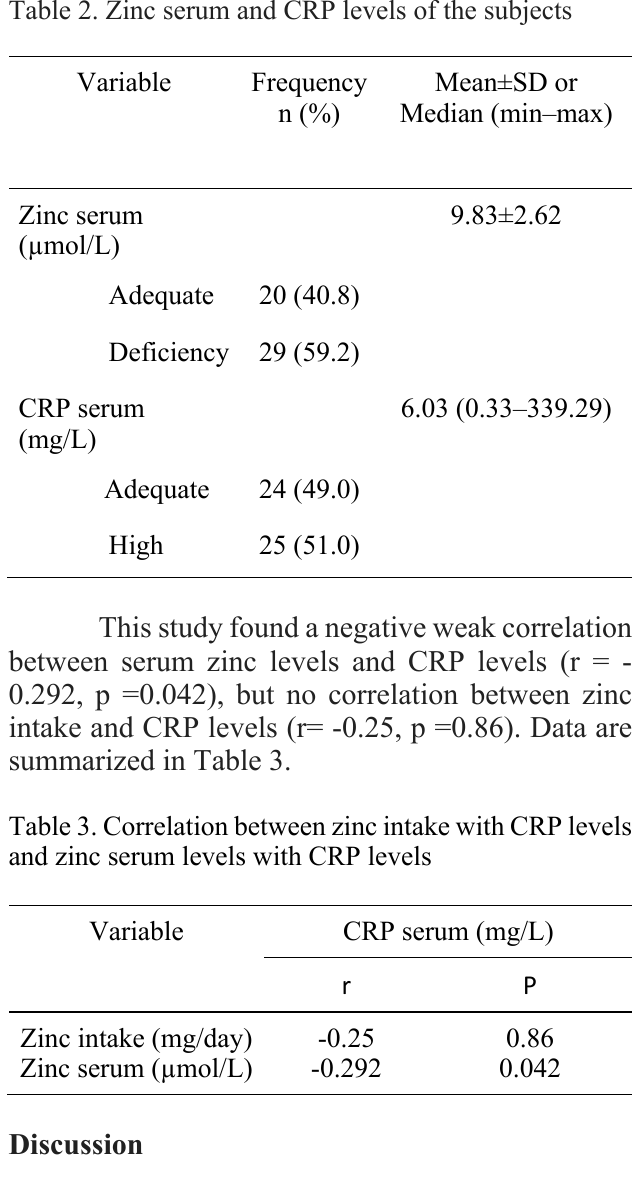
Table 2. Zinc serum and CRP levels of the subjects